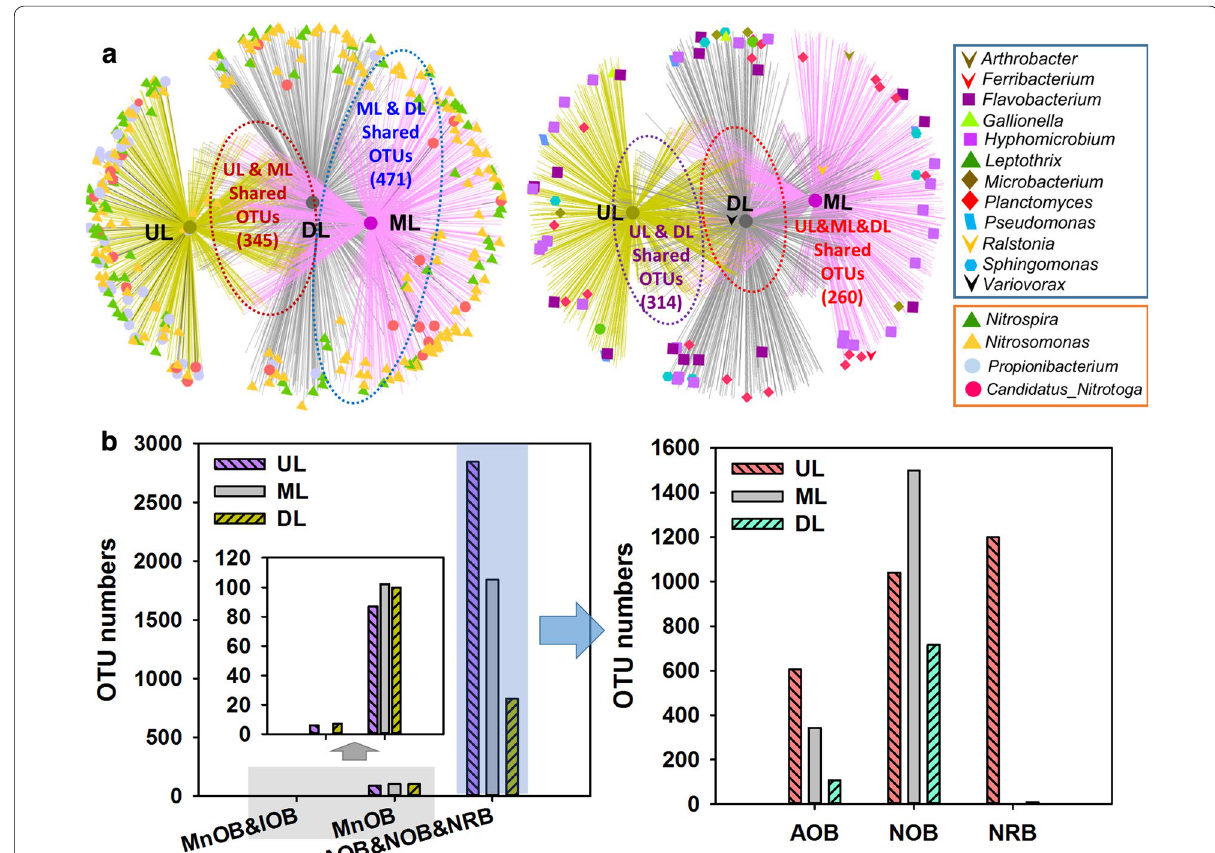
Fig. 3 OTU networks of specific functional genera in the three bacterial communities ( a ). Genus level identification of the specific functional bacte- rial sequences (Unit: Number of OTUs) ( b